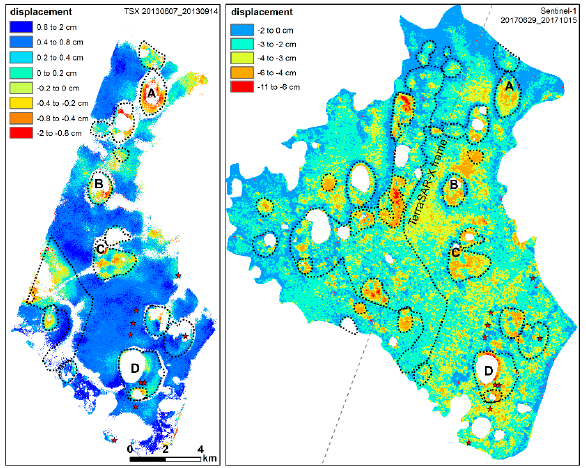
Figure 13. Summer displacement maps for a southern part of the Lena River Delta (Kurungnakh-Sise Island) in the vertical direction from TerraSAR-X data in 2013 [14] and in the line-of-sight direction from Sentinel-1 data in 2017. Large water bodies are clipped out. Thermokarst basins are delineated manually in dashed black. Locations of in-situ measurements are shown with red stars.